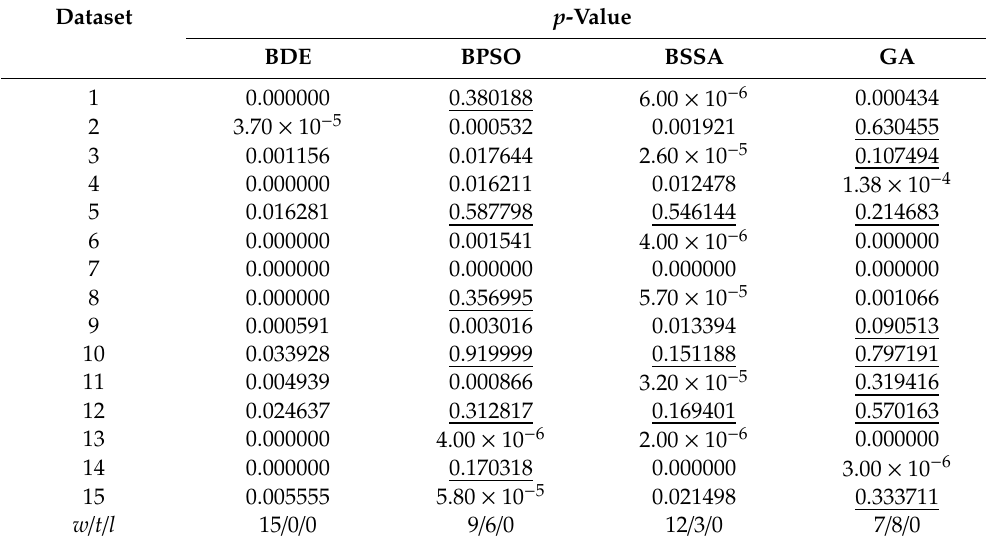
Table 5. p -values of the Wilcoxon rank sum test of the BCSO accuracy results versus other algorithms.